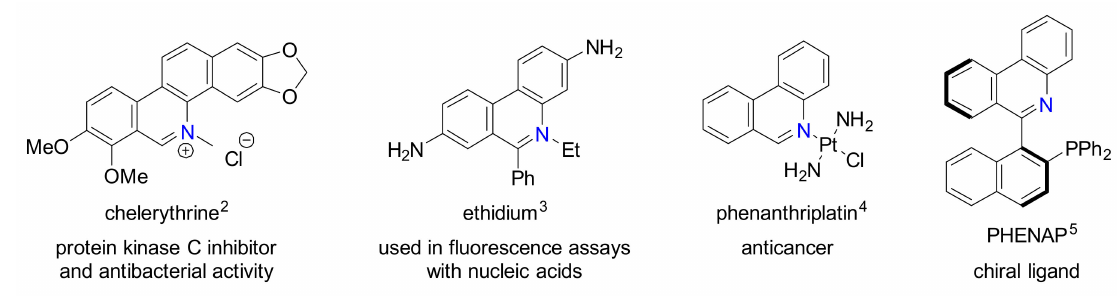
Figure 1. Examples of phenanthridine